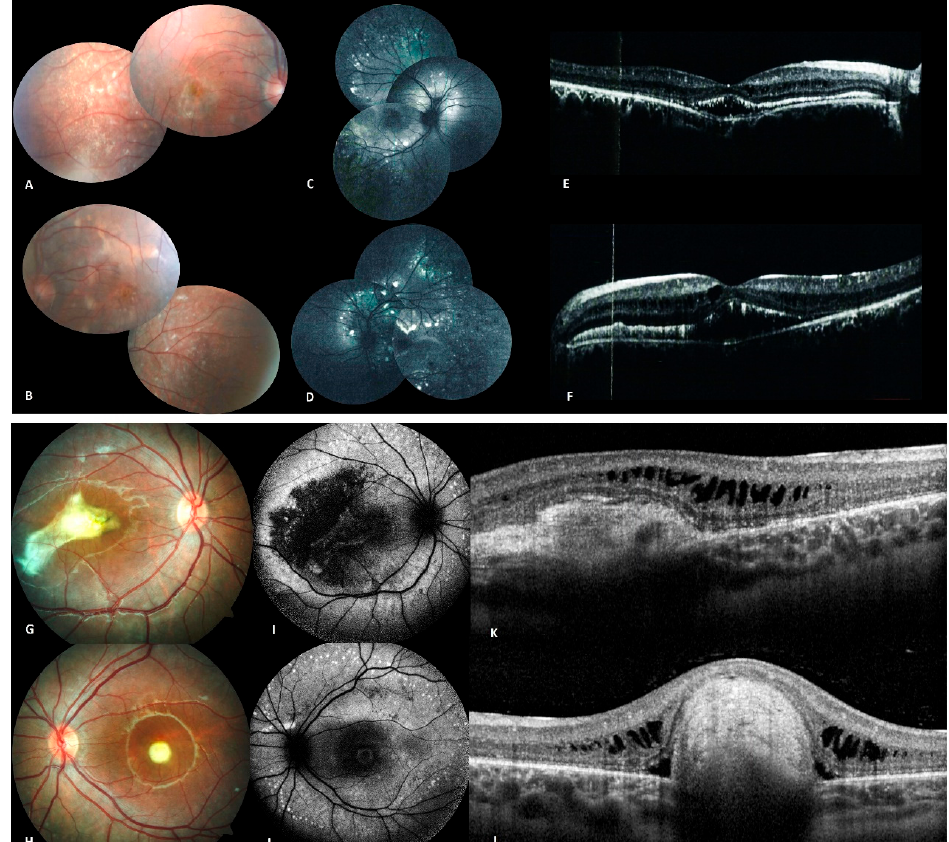
Figure 3. Clinical and imaging features of patients from family D ( A – F ), and family E ( G – L ). ( A , B ) Fundus photographs of both eyes of propositus (II.1) from family D showing multiple yellowish round vitelliform lesions, as well as subretinal fibrosis. ( C , D ) Autofluorescence image of both eyes showing hyper autofluorescent dots in the posterior pole and along the vascular arcades. ( E , F ) OCT with hyperreflective macular subretinal deposits with intra-retinal cysts. ( G , H ) Fundus photography of both eyes of propositus (II.1) from family E showing a macular yellow lesion with fibrosis in the right eye and a macular yellow round lesion in the left eye. ( I , J ) Autofluorescence image of both eyes with autofluorescent dots scattered along the vascular arcades. ( K , L ) OCT showing subretinal deposits with intraretinal fluid in the right eye and a subretinal mass in the left eye.